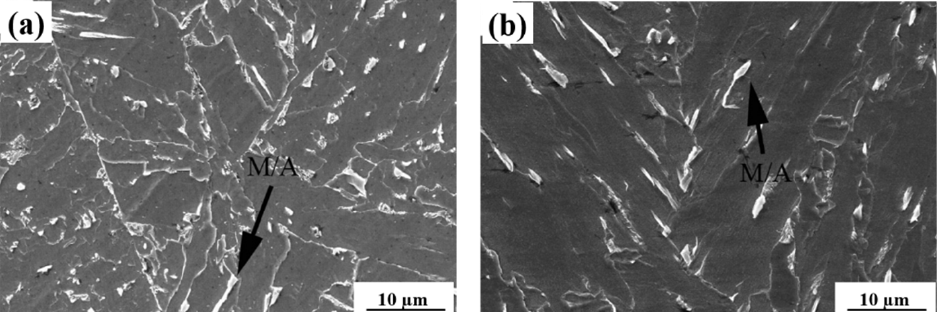
Figure 6. SEM images of simulated CGHAZ with a heat input of 200 kJ/cm with ( a ) 0.073% Nb and ( b ) 0.110% Nb.